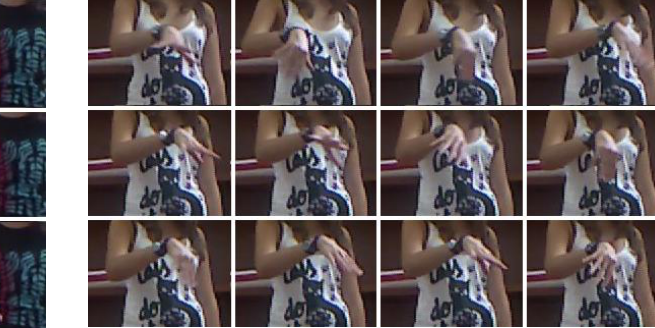
Figure 7. Sample00802, frames 913-970